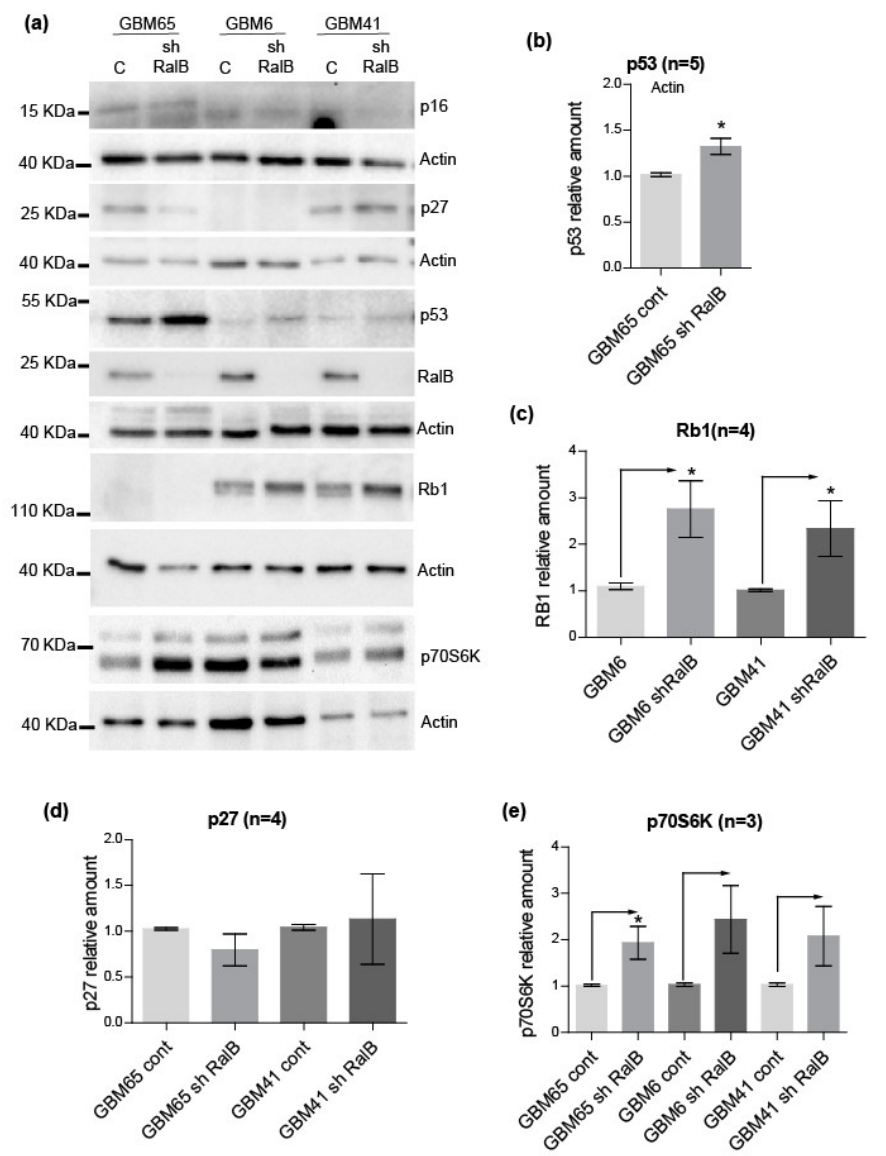
Figure 5. RalB knockdown induces a senescent-like response in primary glioblastoma cells through non- canonical mechanisms. Primary GBM cells growing in the same conditions as in Figure 4 were processed for immunoblot. ( a ) Panels showing the levels of the indicated proteins in primary GBM cells. Actin was used as a loading control. Quantification of the protein levels for p53 ( b ), Rb1 ( c ), p27 ( d ), and Phosphop70S6K ( e ). The number of independent experiments ( n ) is shown in the panels. The mean ± SEM is shown. Significance was determined by ANOVA or t -test ( p ≤ 0.05, *).